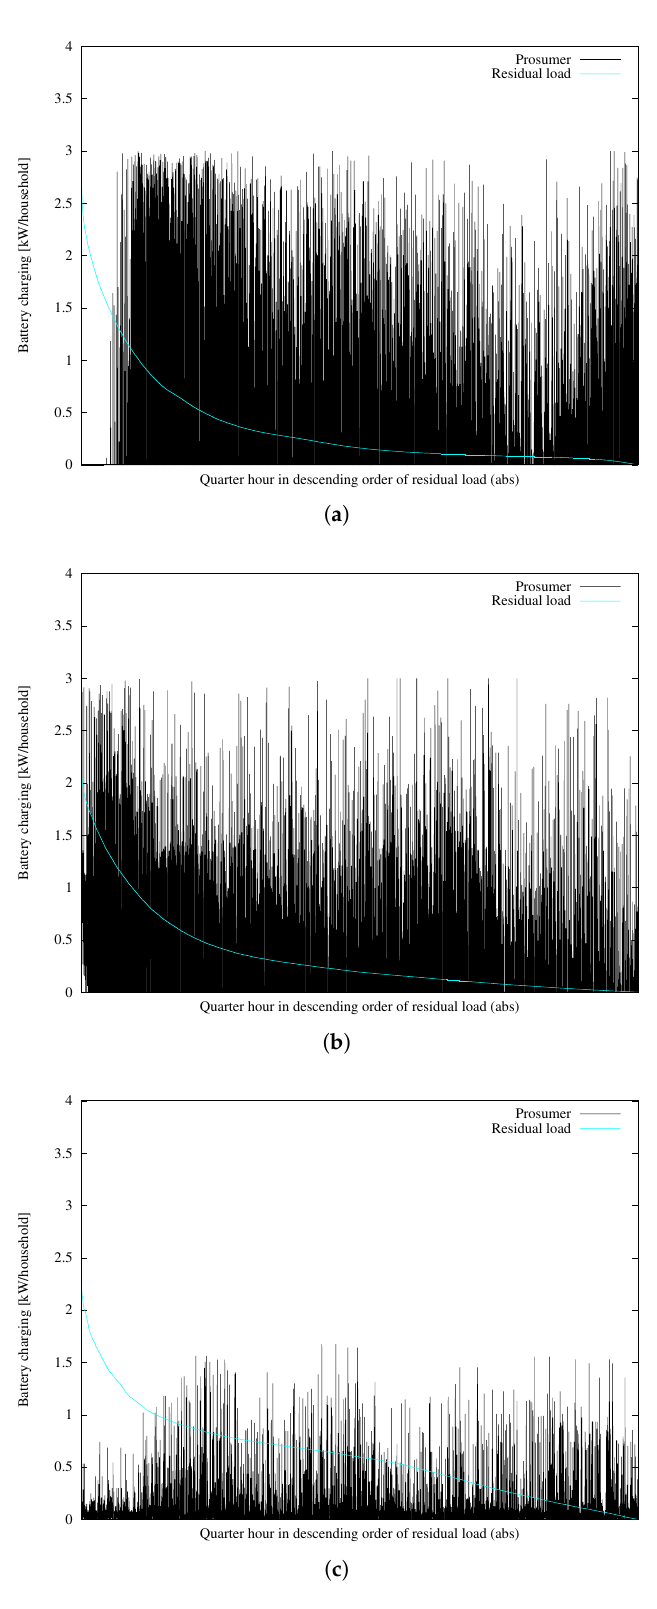
Figure 6. Annual residual load duration curves (absolute values; cyan) and battery charging (black); by battery operation mode); for 75% prosumer penetration ratio. ( a ) Battery operation mode 1; ( b ) Battery operation mode 2; ( c ) Battery operation mode